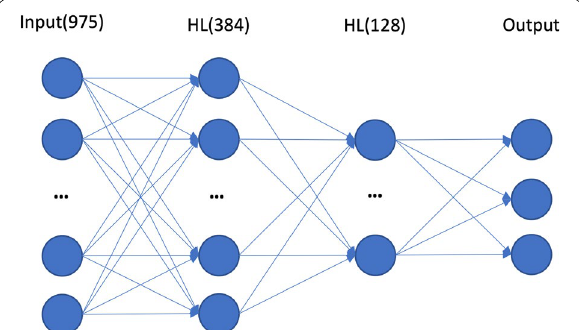
Fig. 2 Neural network architecture, with the inputs on the left side, two hidden layers (HL) and the 3‑dimensional output standing for the 3‑axis calibrated